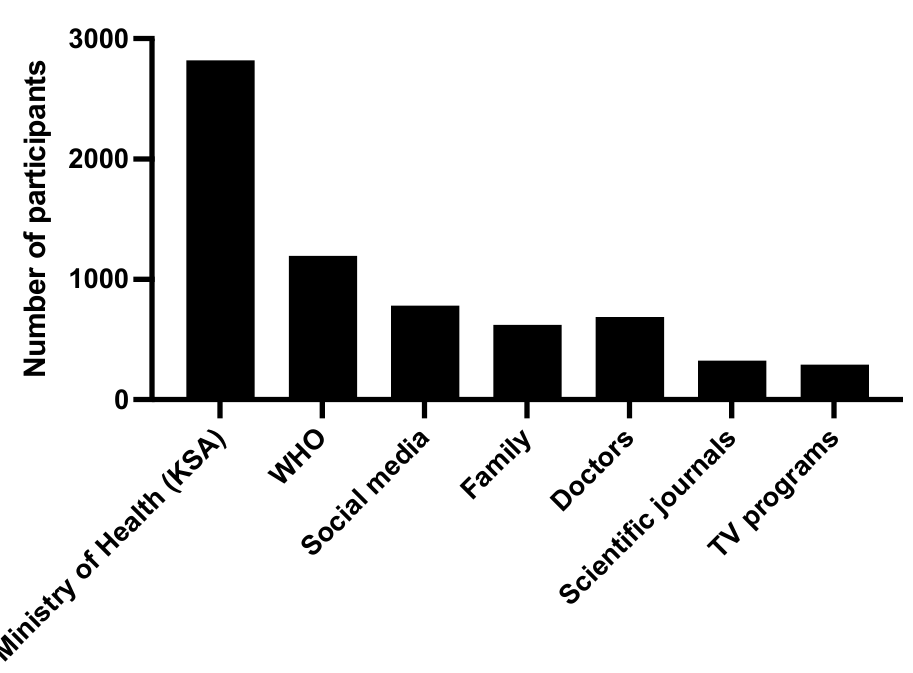
Figure 3. The sources of the information regarding COVID-19 vaccinations.